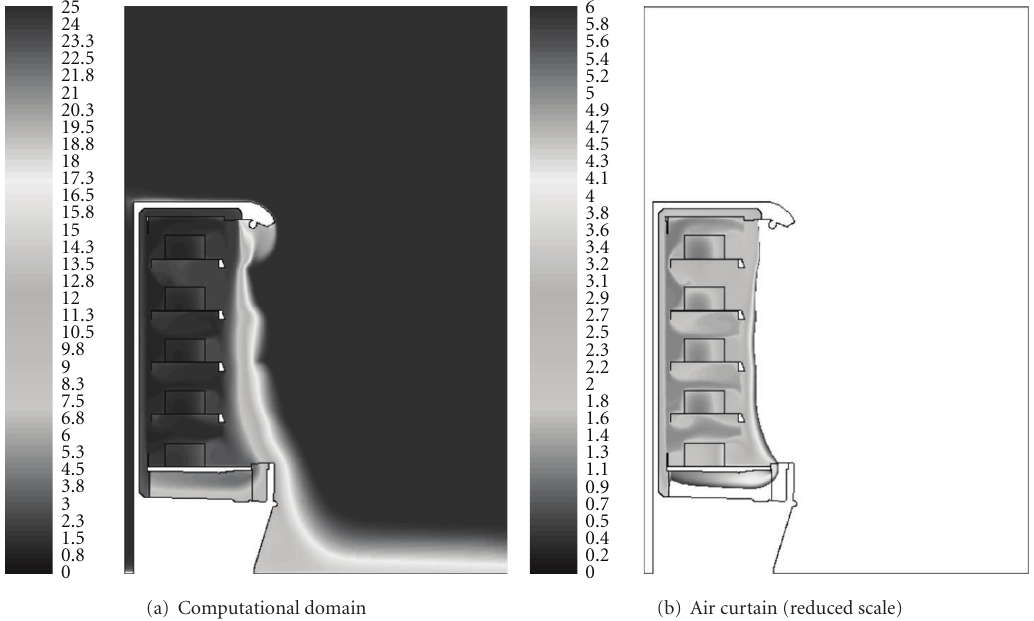
Figure 13: Temperature field numerical predictions, T [ ◦ C]—OPTg case study.